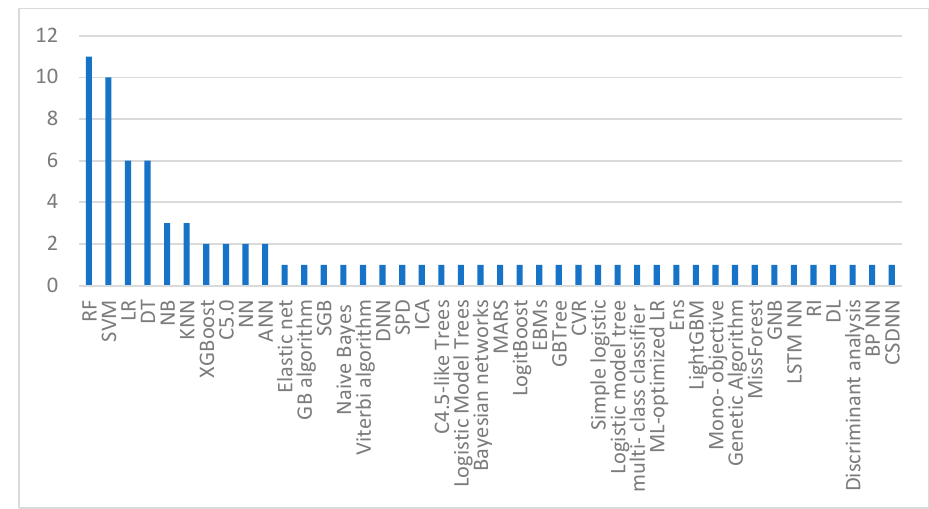
Figure 1. Widely implemented ML and DL algorithms in previous studies.